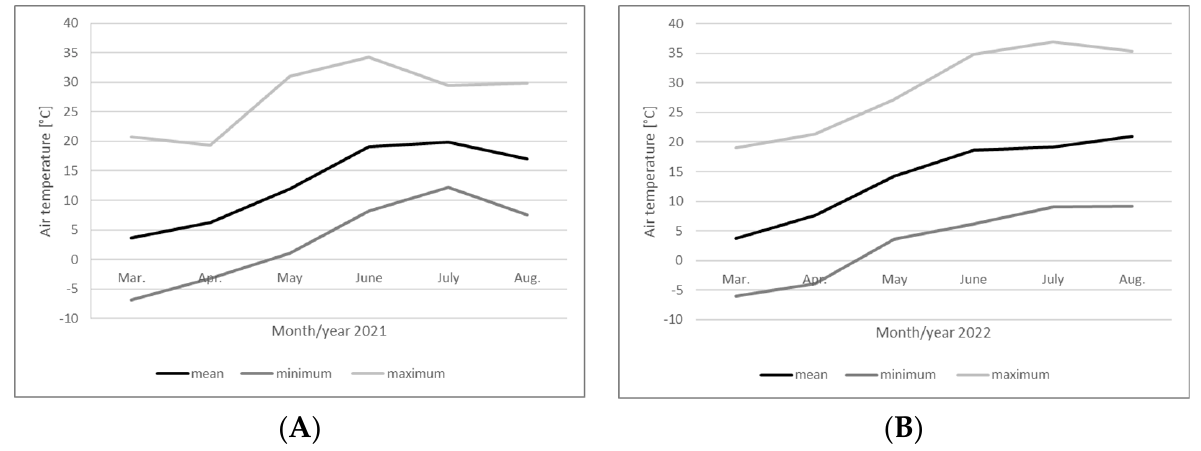
Figure 2. Air temperature [°C] during the growing seasons: ( A ) year of establishment of flower strip (2021); ( B ) year of observations (2022).